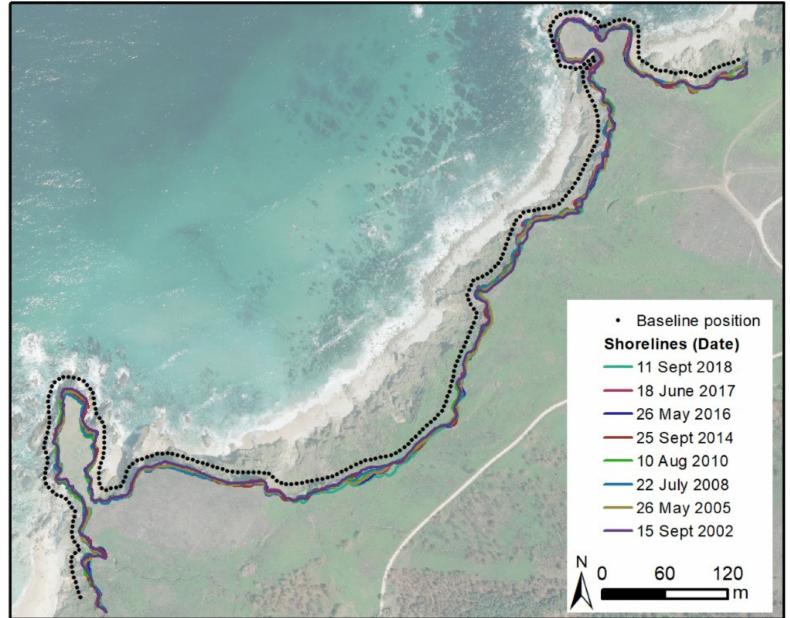
Figure 3. Example baseline used in the ODSAS process for site A04. The black dots show the baseline position at 5 m apart, and colored lines mark the shoreline position at each